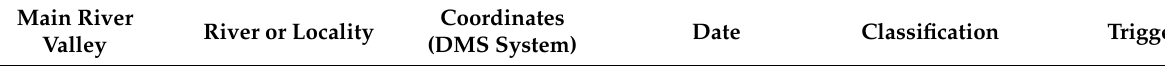
Table 1. Historic records of debris flows in Chilean central Andes (30 ◦ –33 ◦